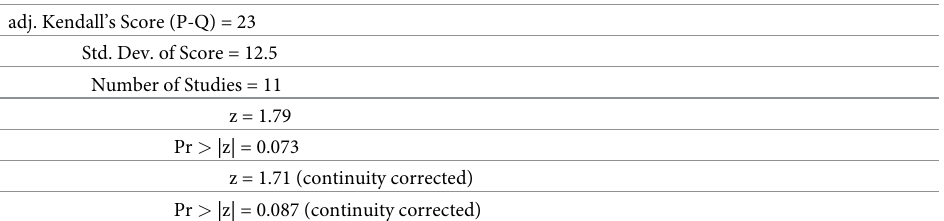
Table 4. Begg’s test for funnel